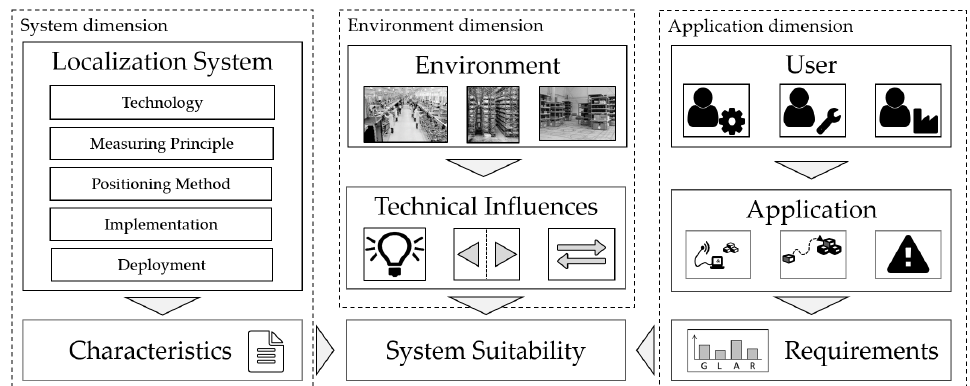
Figure 1. Matching requirements and localization systems—a multi-dimensional